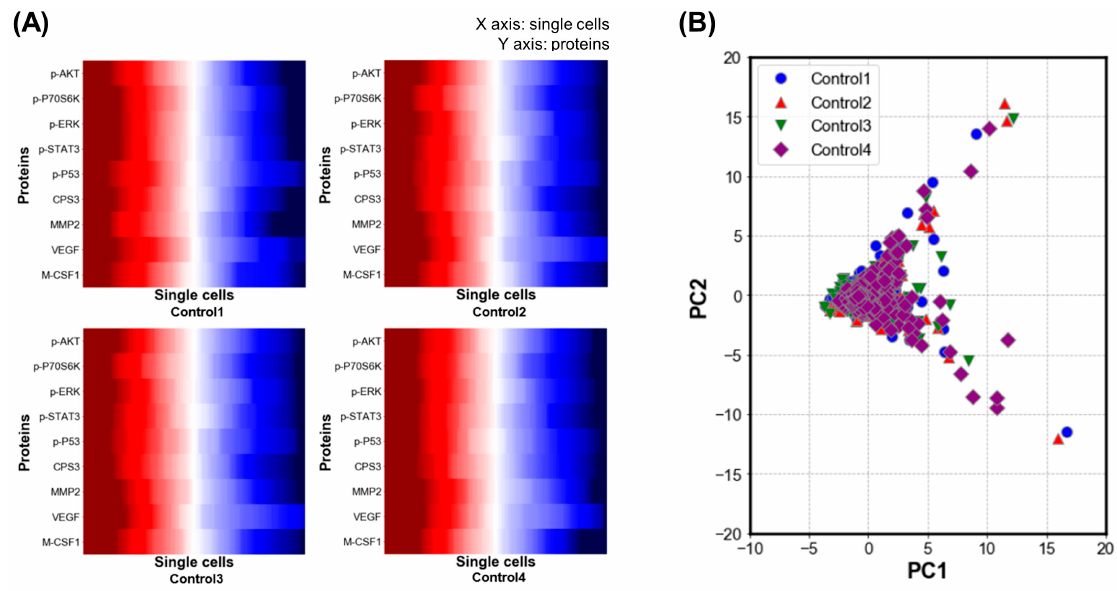
Figure 6. Cancer-cell heterogeneity evaluation. ( A ) Heat maps for protein concentration in four control groups at the single-cell level are shown. ( B ) Principal component analysis for the four control groups is shown.